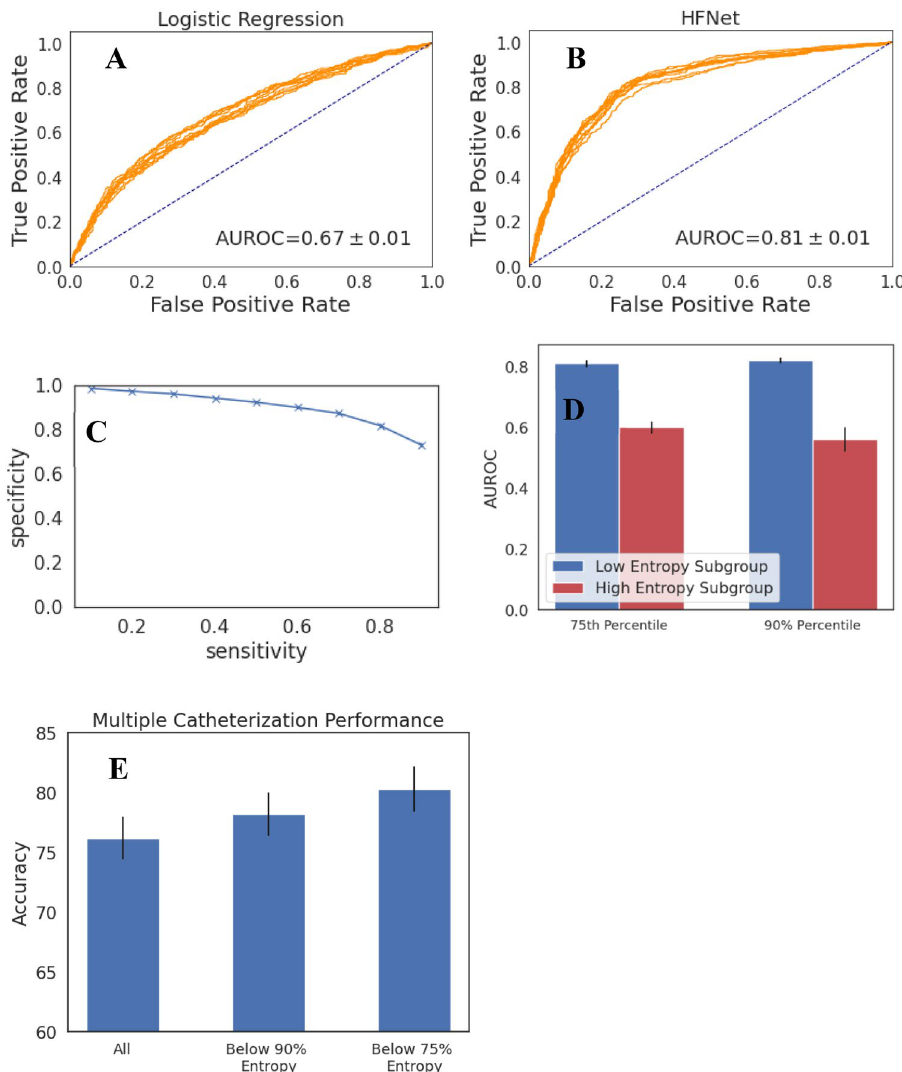
Figure 6. Validation on external dataset. On a dataset from a second institution, showing: ( a ),( b ) Receiver Operator Characteristics for baseline logistic regression and HFNet over 10 bootstraps; ( c ) Performance stratified by prediction uncertainty score showing mean and standard deviation over 10 bootstraps; ( d ) Sensitivity and Specificity and PPV/NPV on the external dataset showing mean and standard deviation over 10 boostraps; ( e ) Sequence accuracy for patients with multiple catheterizations, showing mean and standard error (N = 281). The performance trends demonstrated on the internal test set are consistent in the external validation